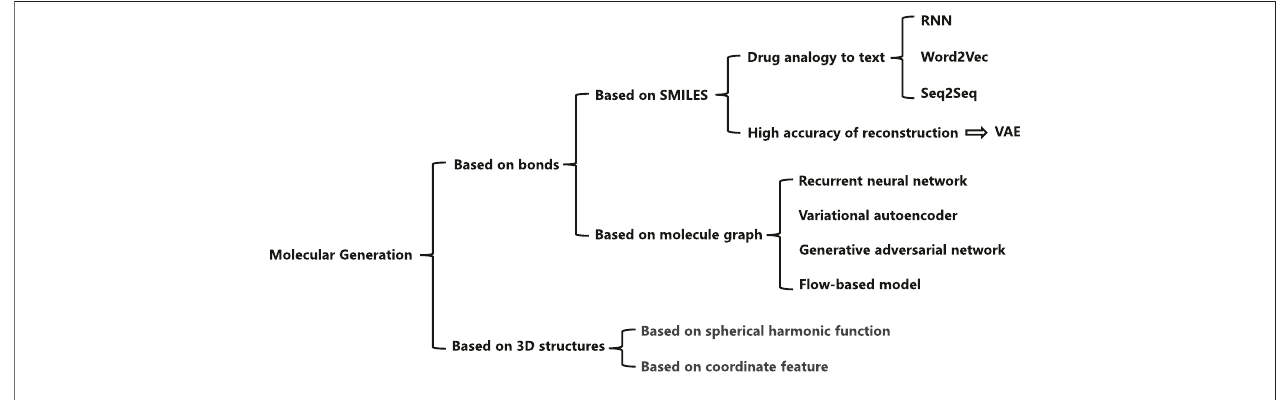
FIGURE 1 | Current work on molecular generation for drug